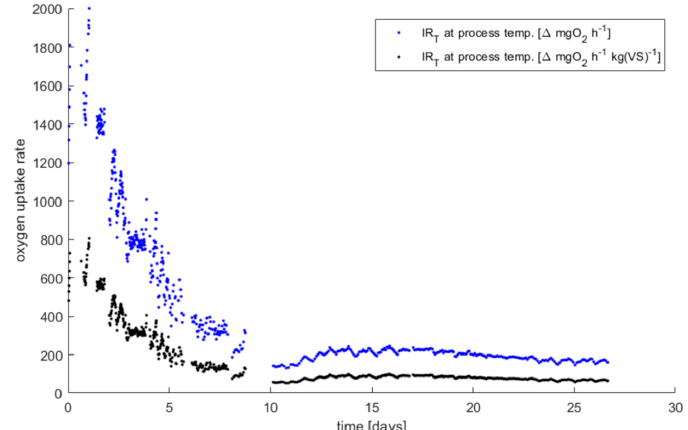
Figure A3. The oxygen consumption rate (blue dots) is normalized to the initial volatile solids present in the bioreactor, obtaining the final DRI at the process temperature (black dots)—data referred to the MIX 25%.